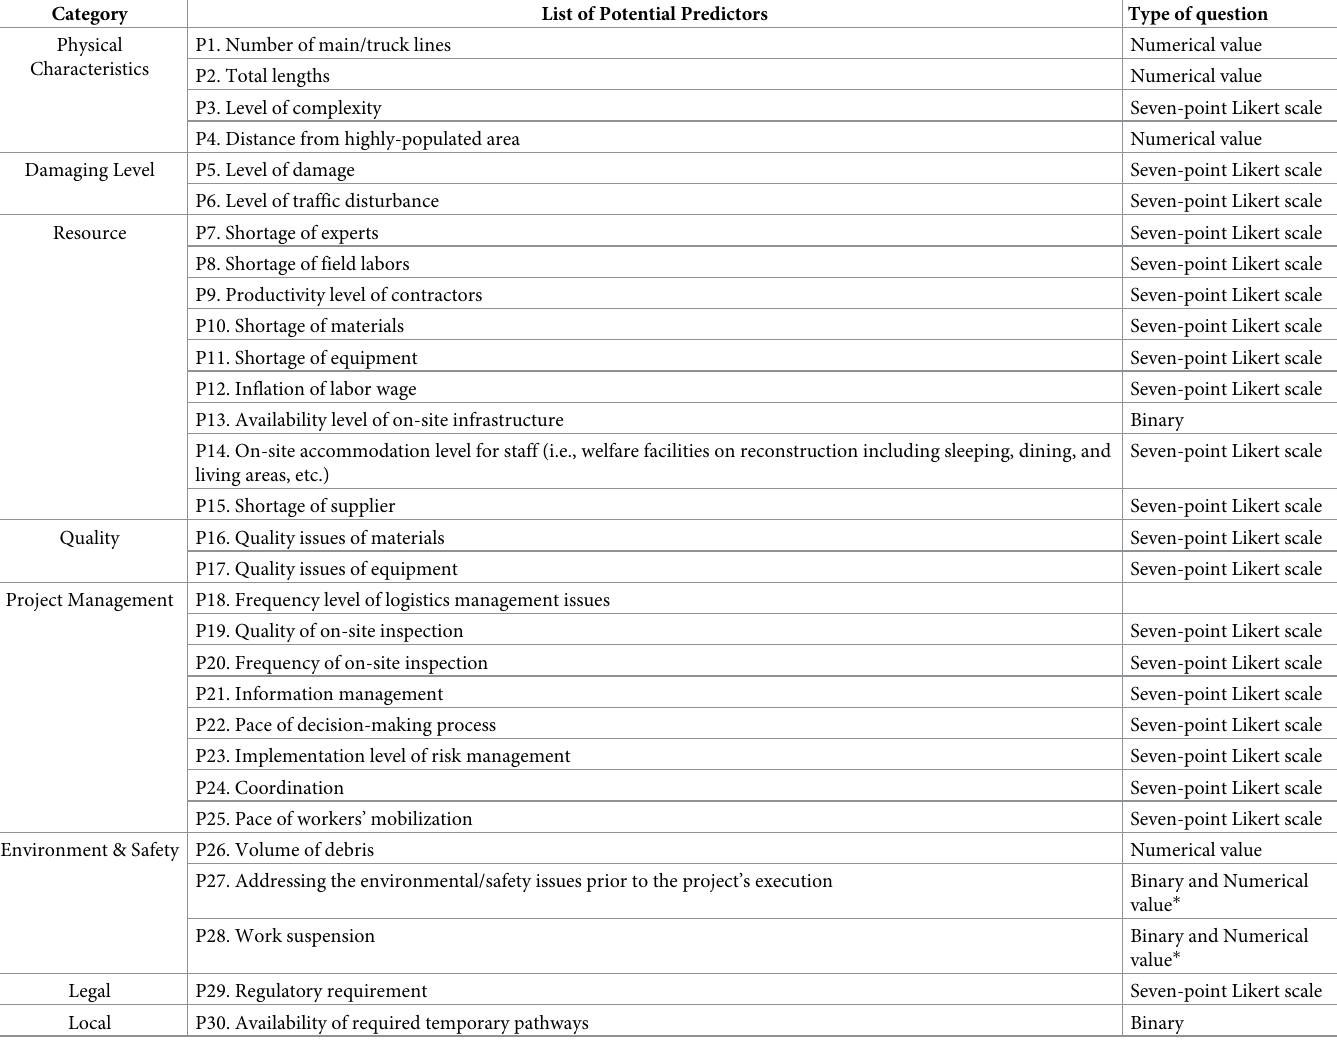
Table 2. List of potential cost and schedule performance predictors and type of survey